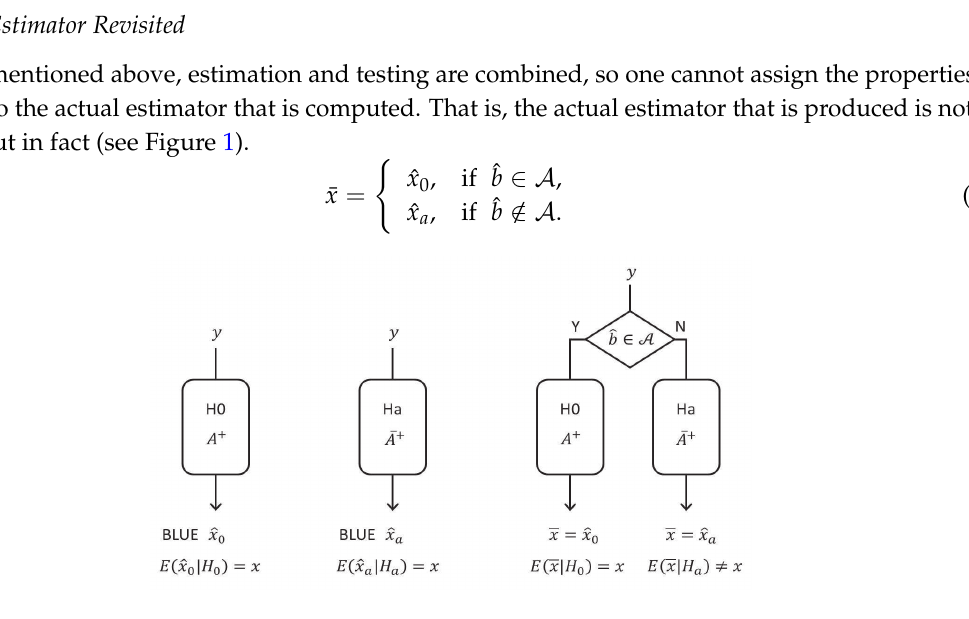
Figure 1. (left) H 0 known: ˆ x 0 is BLUE of x ; (middle) H a known: ˆ x a is BLUE of x ; (right) H 0 and H a selected under chance: ¯ x not a BLUE of x (cf. (10), (12) and